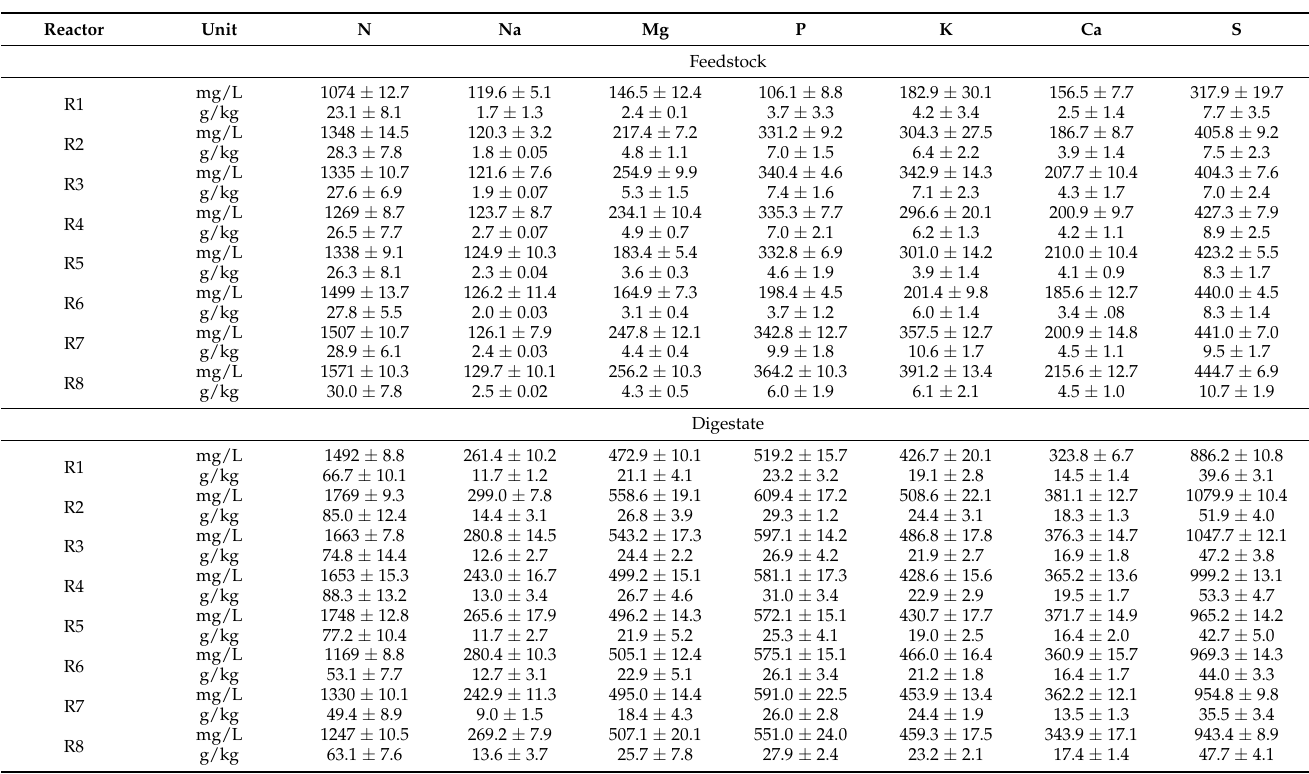
Table 3. Contents of macro-elements in the experimental series (average values and standard deviations are